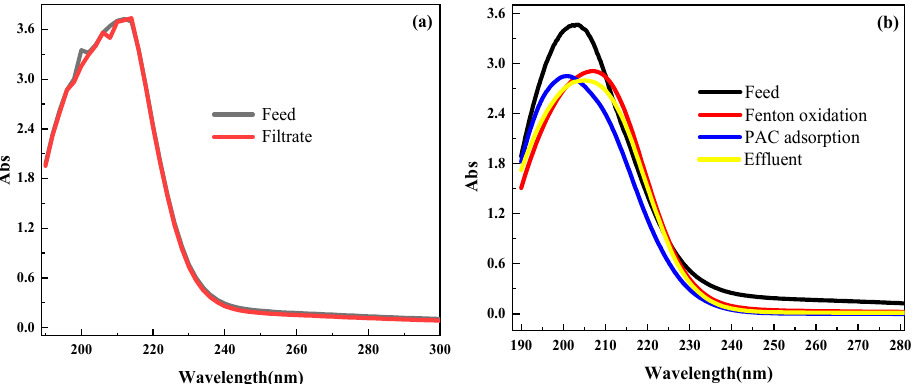
Figure 4. The changes in UV-vis for varied effluents: ( a ) the changes in UV-vis during the direct filtration using the ceramic membrane; ( b ) the changes of UV-vis in each phase of the combined process. The wavelength range was 190~600 nm, the scanning step was 0.25 nm and the optical path of the quartz colorimeter was 10